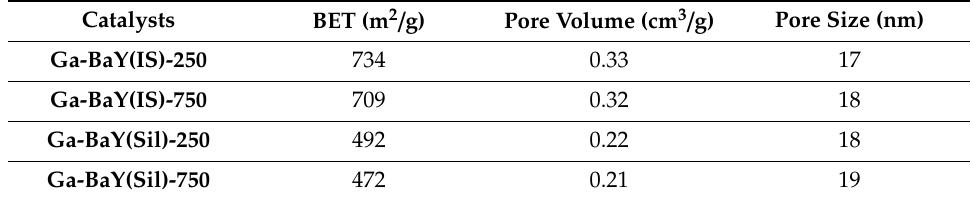
Table 2. Surface properties of Ga-BaY(IS) and Ga-BaY(Sil) calcined at different temperatures.